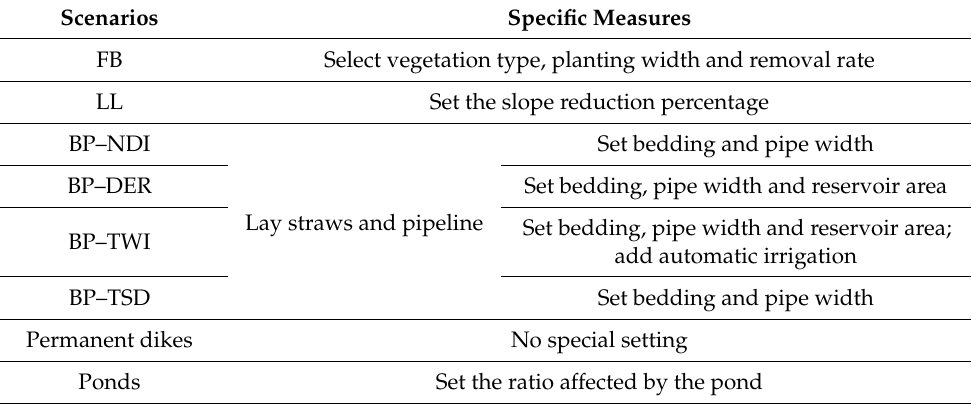
Table 2. Scenarios management setting in